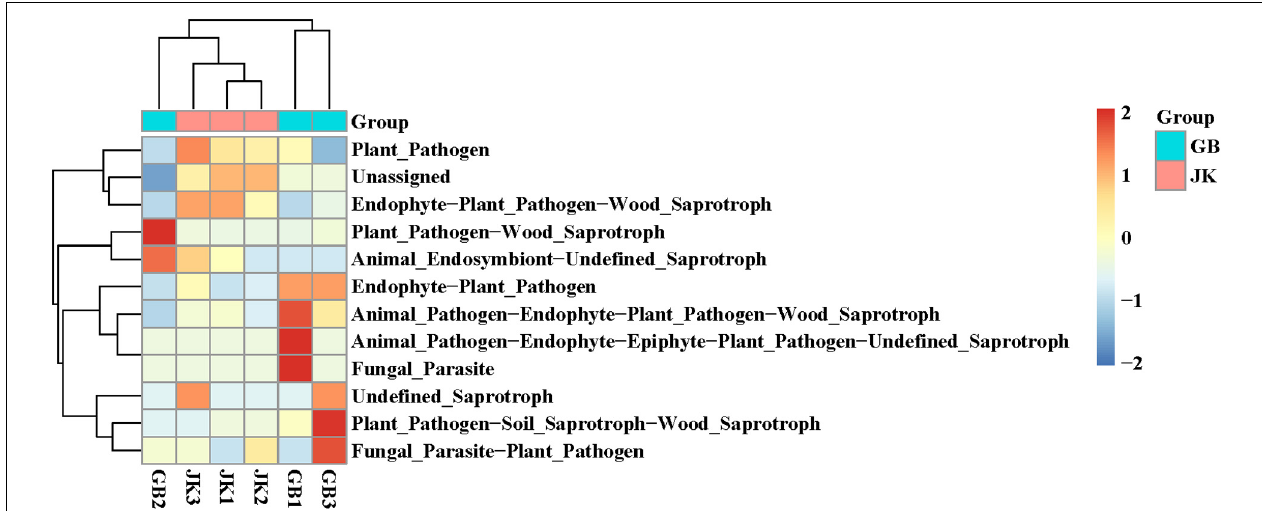
FIGURE 4 | Dendrogram of fungal functional categories in symptomatic (GB1, GB2, GB3) and asymptomatic samples (JK1, JK2, JK3) analyzed using FUNGuild.